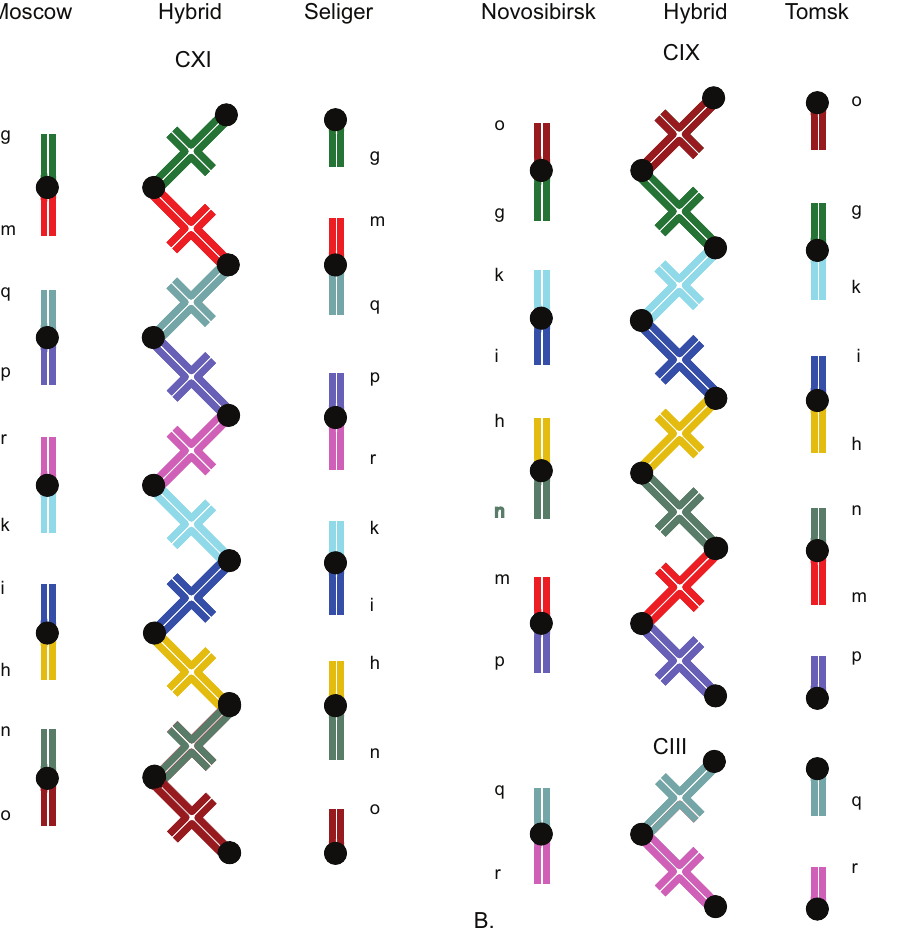
Figure 1. Karyotypes of Sorexaraneus. Metacentric chromosomes of pure race and hybrid individuals at the Moscow-Seliger hybrid zone (A) and the Novosibirsk-Tomsk zone (B). Homologous arms are labeled and color coded.